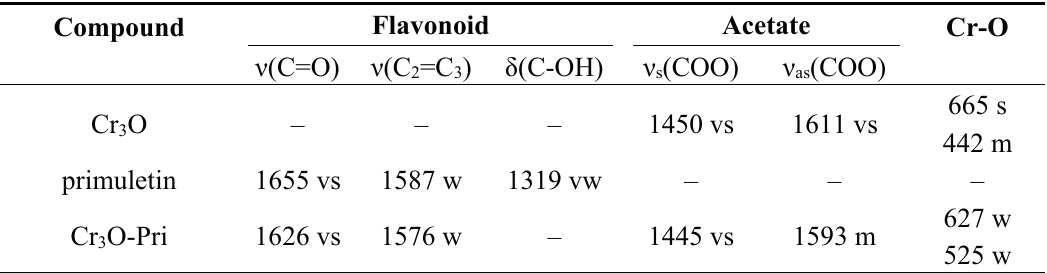
Table 3. FTIR data for free primuletin (HPri), precursor [Cr 3 O(CH 3 CO 2 ) 6 (H 2 O) 3 ] (Cr 3 O),